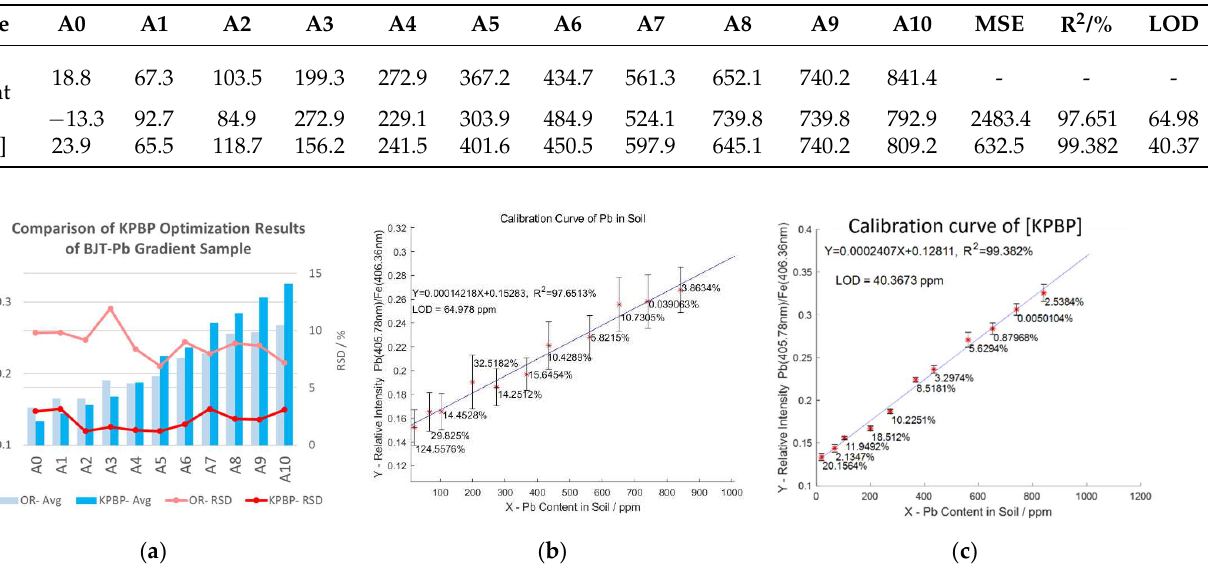
Figure 14. Quantitative analysis results of lead-containing gradient Beijing soil samples by the internal standard method. ( a ) The average relative intensity and RSD of Pb 405.78 nm from the original spectra and the KPBP results. ( b ) Calibration curve of lead-containing gradient Beijing soil samples calculated from the original spectra. ( c ) Calibration curve of lead-containing gradient Beijing soil samples calculated from the KPBP-standardized spectra. Table 2. The true lead content in each sample and the predicted content in each sample calculated by the leave-one-out method (unit ppm unless noted).